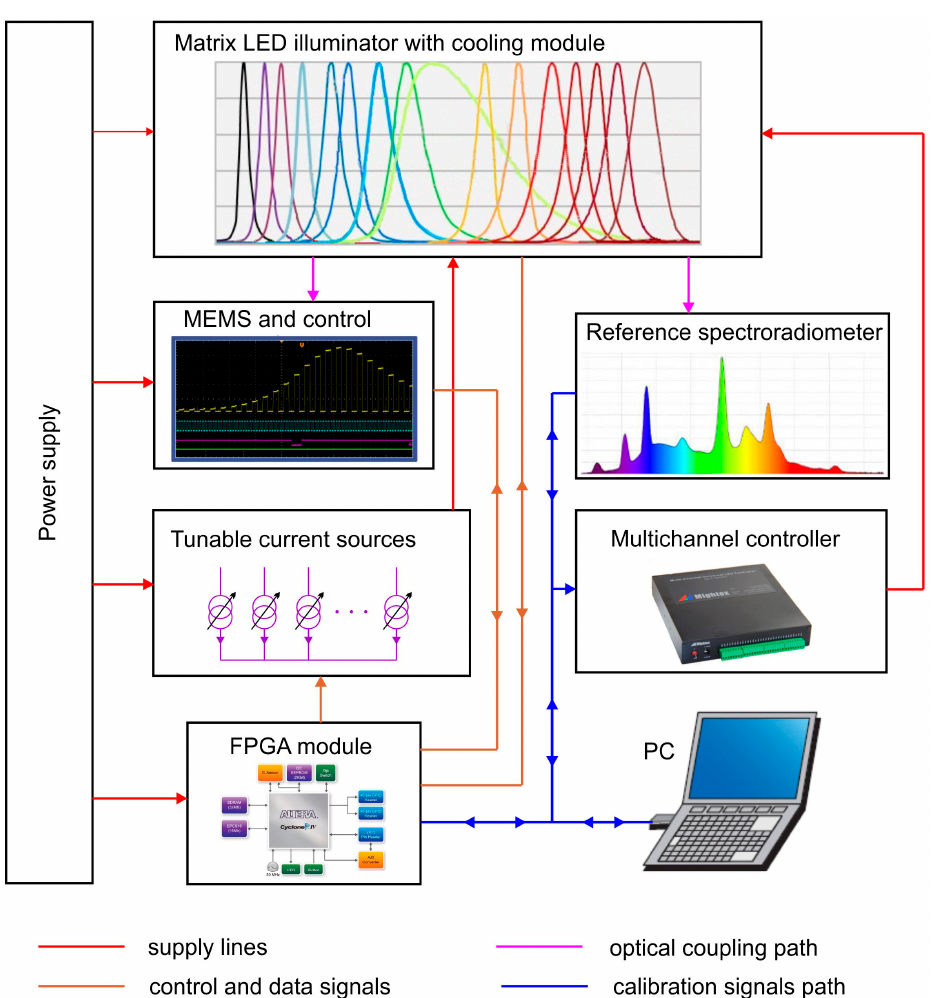
Figure 4. Architecture of the adaptive LED source hardware model.